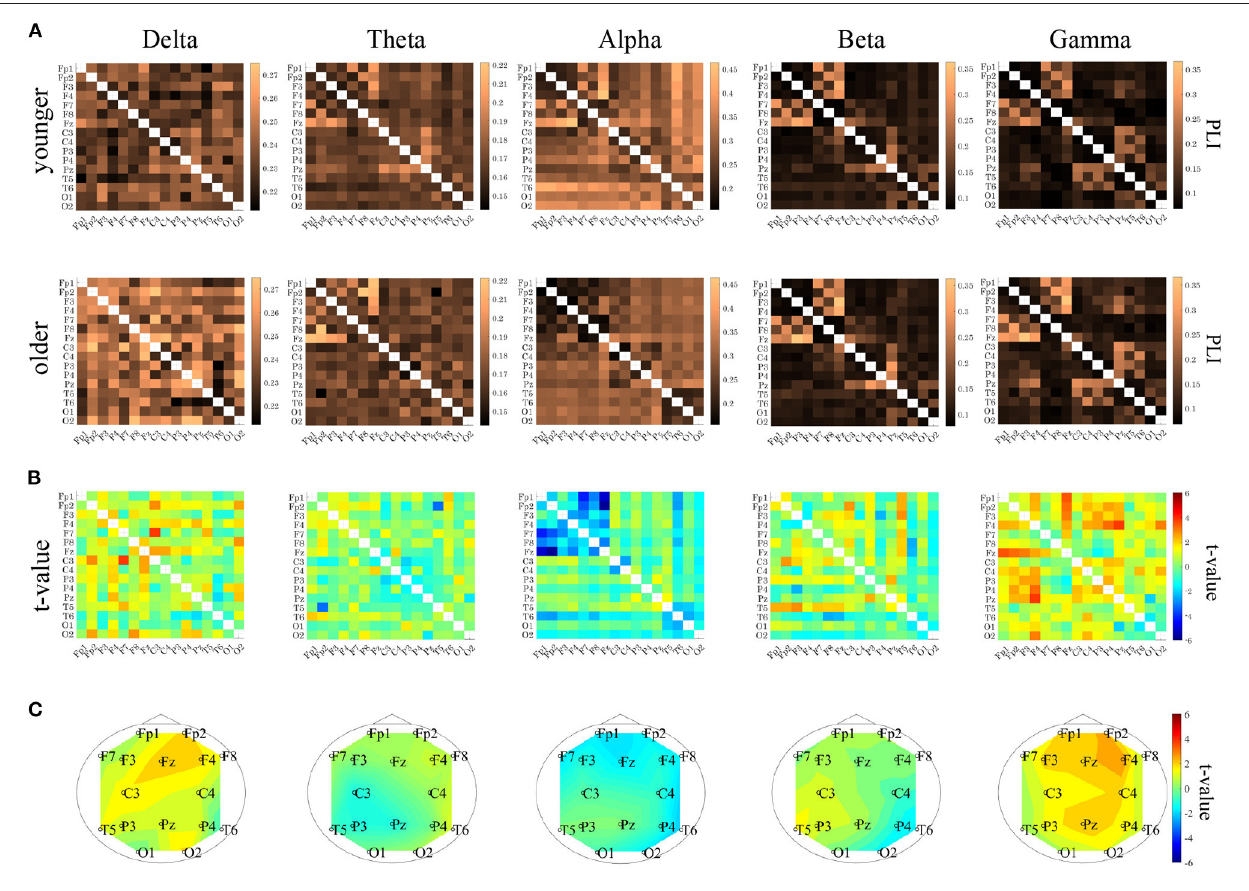
FIGURE 5 | (A) Mean values of phase lag index (PLI) for each band in younger (upper parts) and older (lower parts) groups. (B) t -values between the younger and older groups (upper parts). The warm (cold) colors represents higher (smaller) PLI values in the older group than in the younger group. (lower parts). (C) t -values for the node strength (NS) of PLI between the older and younger groups. Warm (cold) colors represent a higher (smaller) NS for older versus younger individuals. Although no statistically significant differences satisfying with FDR criteria q < 0.05 were observed between the older and younger groups, relatively higher NS at delta and gamma band in the older group was observed. In PLI among pair-wise electrodes, no statistically significant differences satisfying with FDR criteria ( q < 0.05) were observed between the older and younger